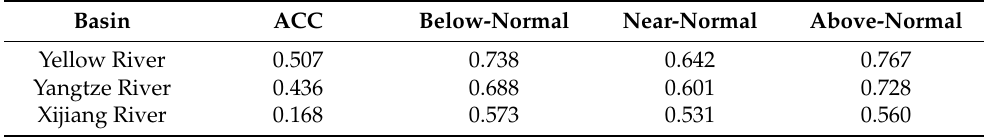
Figure 4. Variation of ROC areas for ( a ) below-normal, ( b ) above-normal, and ( c ) near-normal with the target month for six lead times for the Yellow River.